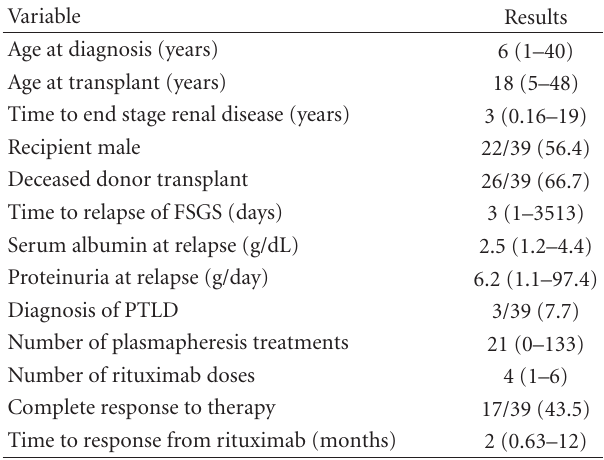
Table 1: Demographic characteristics of renal transplant patients with recurrence FSGS that received rituximab. Values expressed as median (range) or proportion